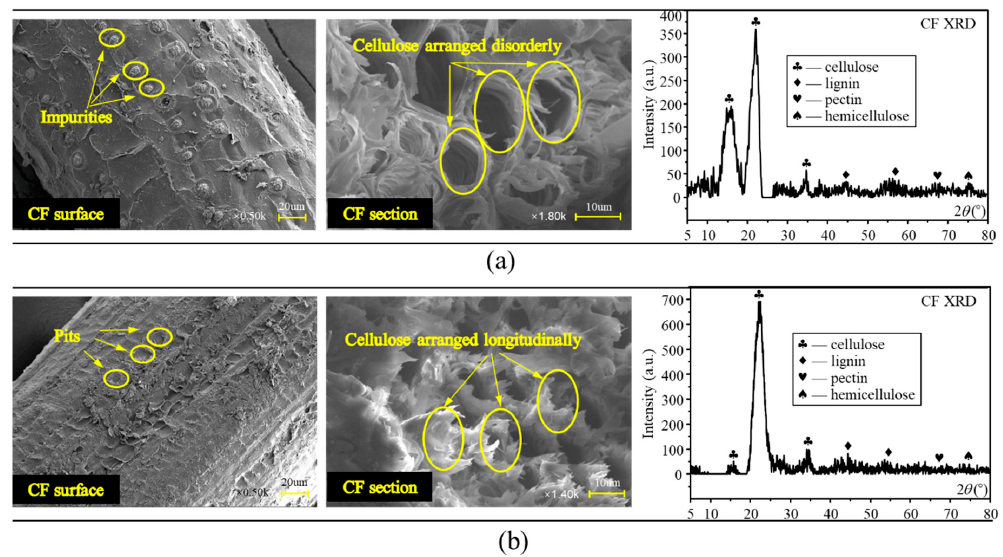
Figure 19. SEM and XRD for CF: ( a ) untreated CF; ( b ) treated